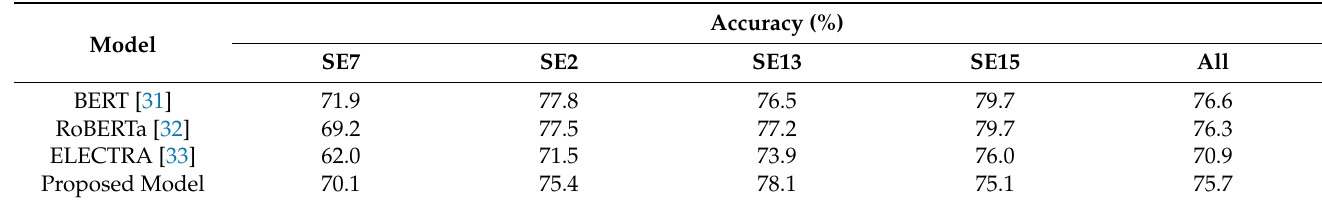
Table 10. SemCor test results.